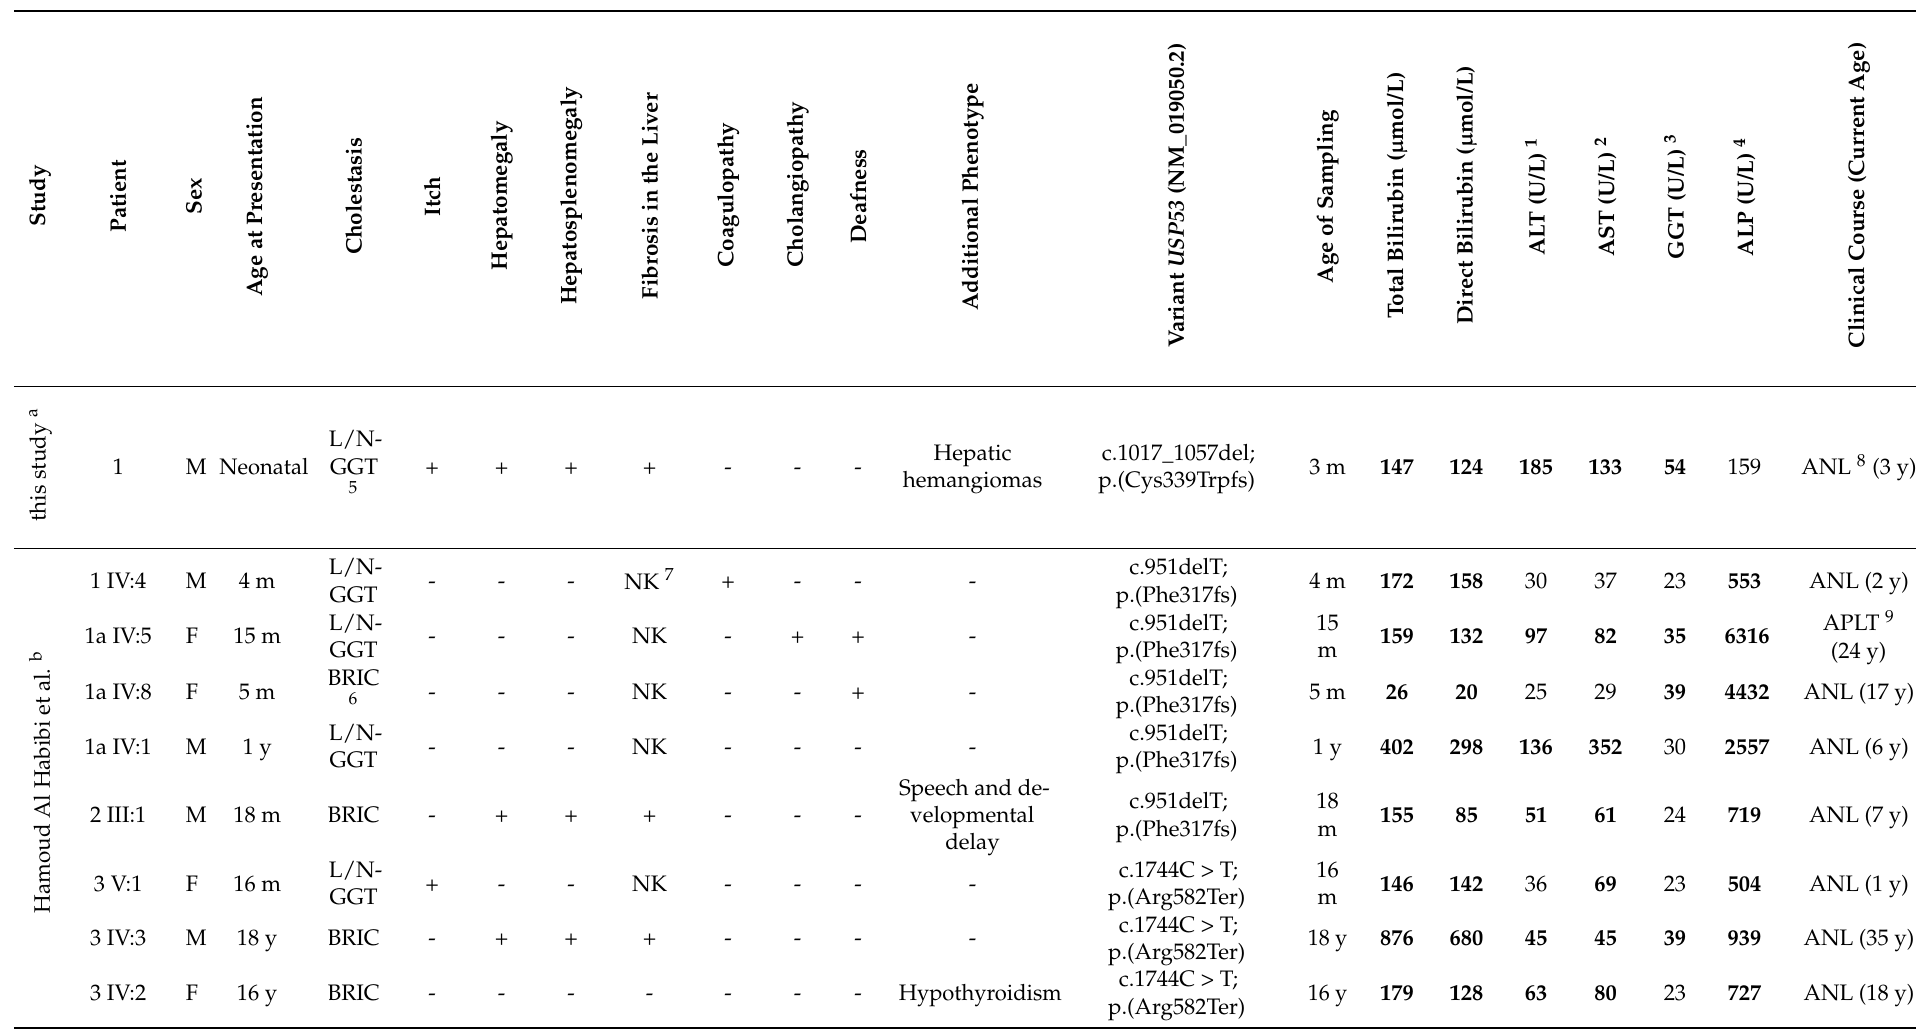
Table 2. Comparing clinical features of the studied patient with previously published